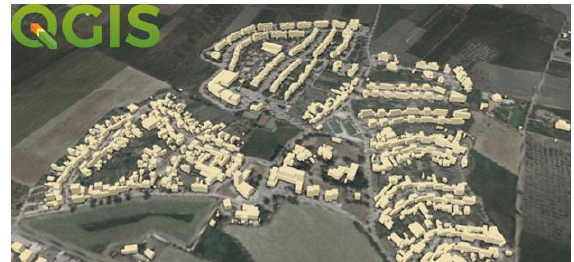
Figure 5. The georeferenced 3D model in QGIS environment.